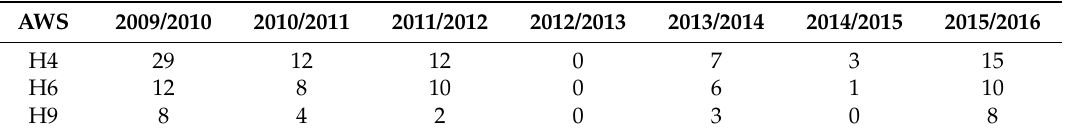
Table 4. Contribution of winter rains to point winter mass balance in % on AWS (H4 = 187 m